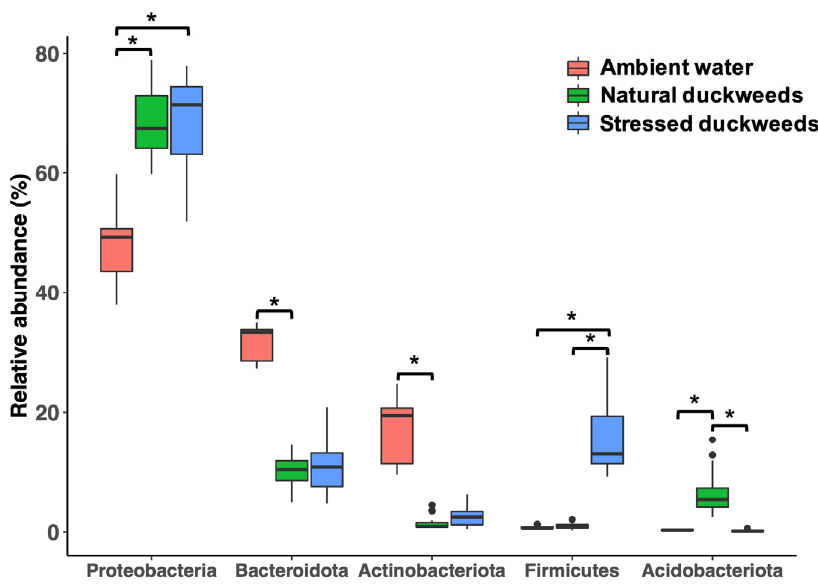
Figure 3. Taxonomic composition of microbial community associated with natural, stressed duck- weeds (nutrient deficiency) and ambient water. The most abundance phyla (>5% median relative abundance) were plotted. Asterisks (*) indicate significant difference based on Wilcoxon test, p -value < 0.05. Dots indicate potential outliers.